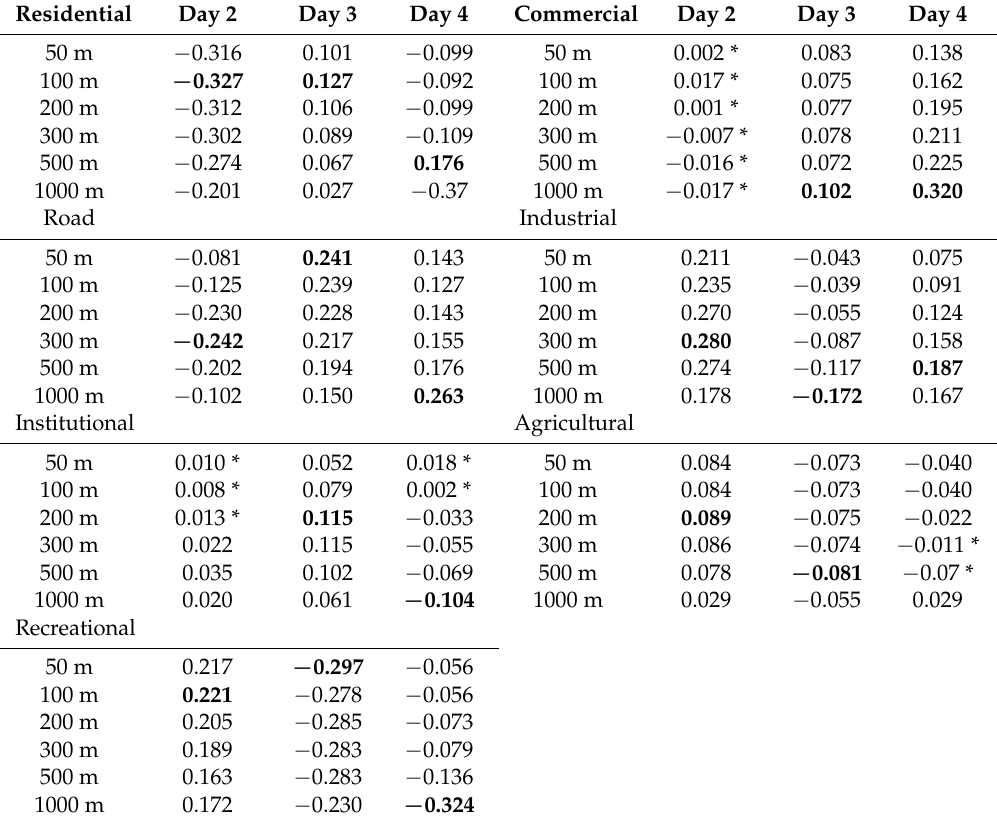
Table 7. Pearson’s R correlation between land use variables and personal PM 2.5